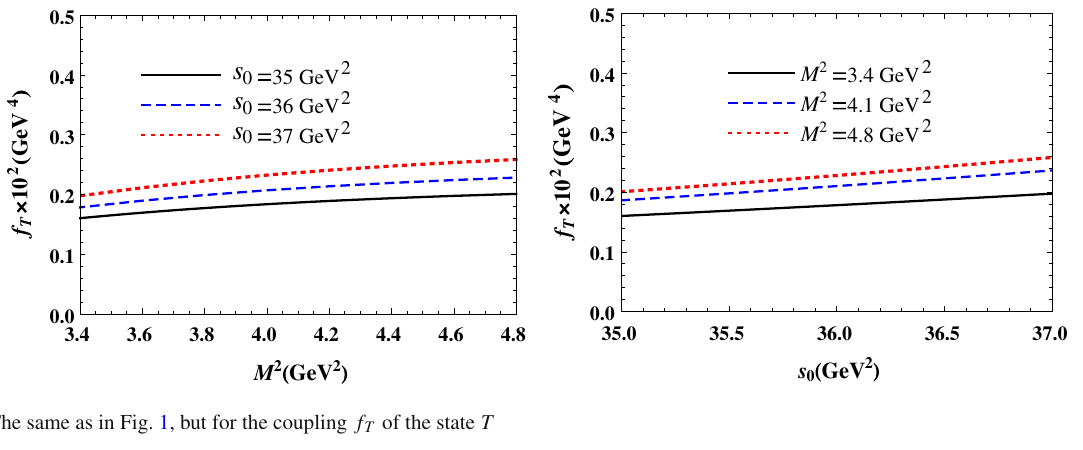
Fig. 1 The mass of the tetraquark T as a function of the Borel parameter M 2 at fixed s 0 (left panel) and as a function of the continuum threshold s 0 at fixed M 2 (right panel)